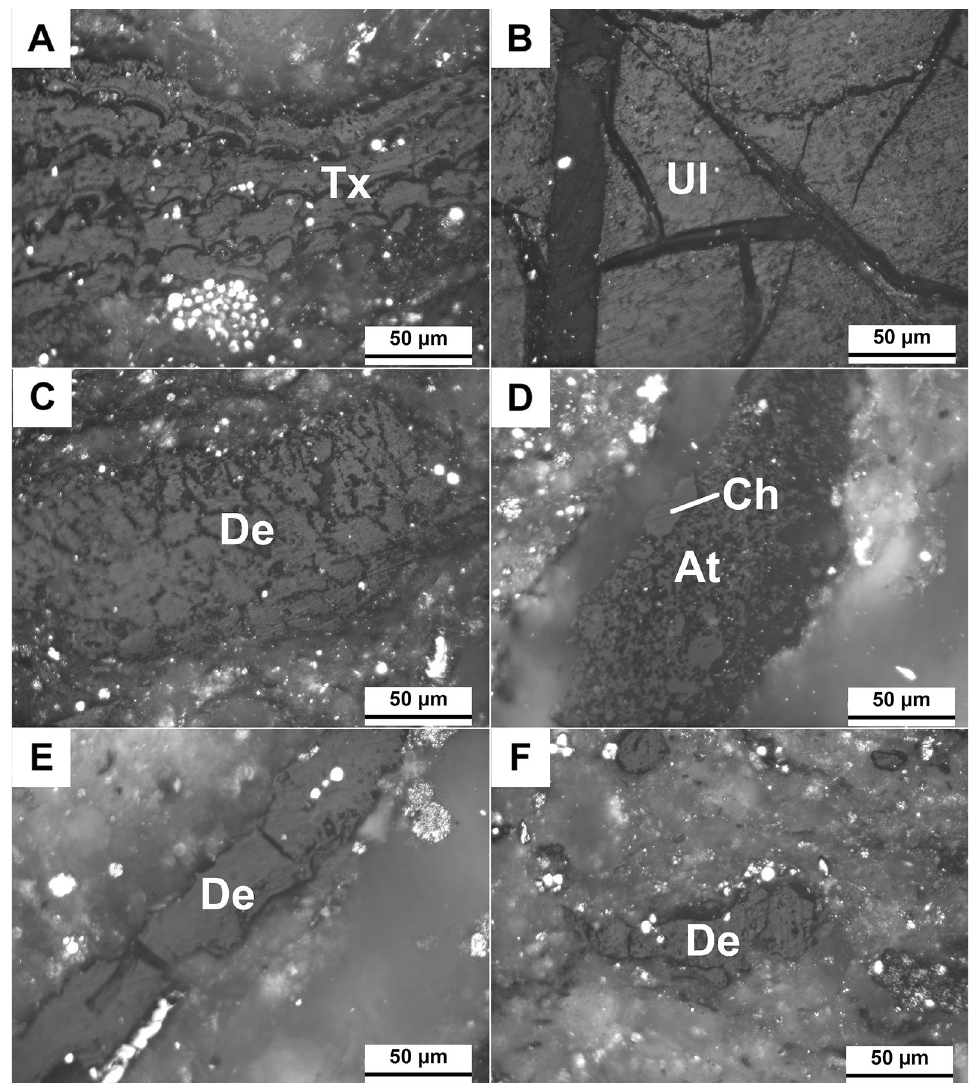
Figure 8. Microphotographs of shale with plant detritus under polarized reflected white light (oil immersion; SC4 sample). ( A ) Fragment of preserved wood with a visible cell structure—textinite (Tx); ( B ) Piece of wood with a damaged cell structure—ulminite (Ul). Visible cracks; ( C ) Accumulation of detritic plant—densinite (De); ( D ) Plant detritus—atrinite (At) with oval clusters of corpohuminite (Ch); ( E ) Laminae of detritic plant— densinite (De); ( F ) Plant detritus dispersed in the rock matrix—densinite (De).